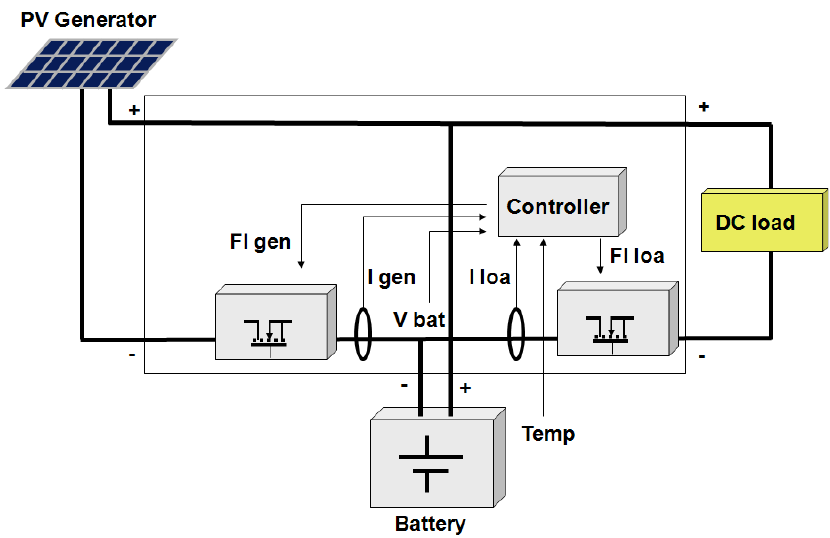
Figure 4. Interconnection of the controller and stand ‐ alone PV system.